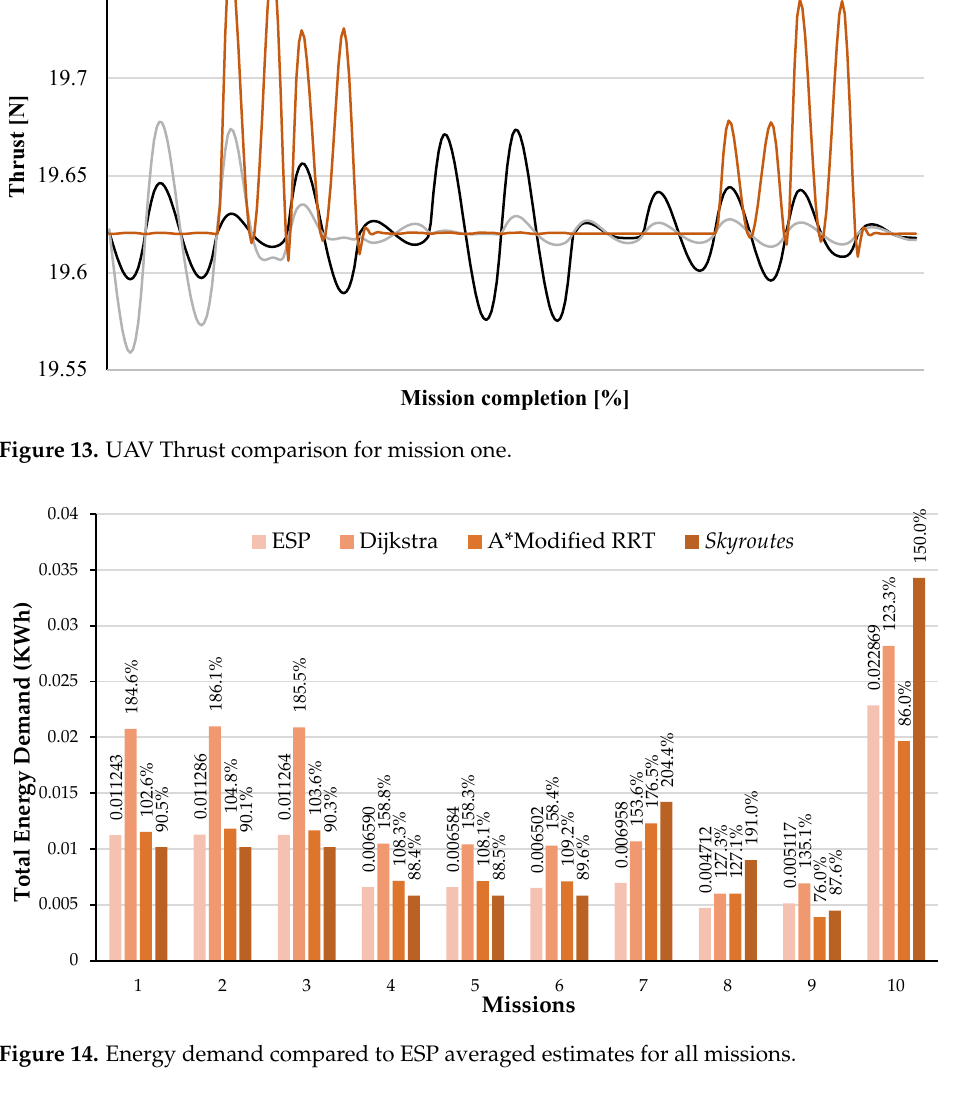
Figure 14. Energy demand compared to ESP averaged estimates for all missions.